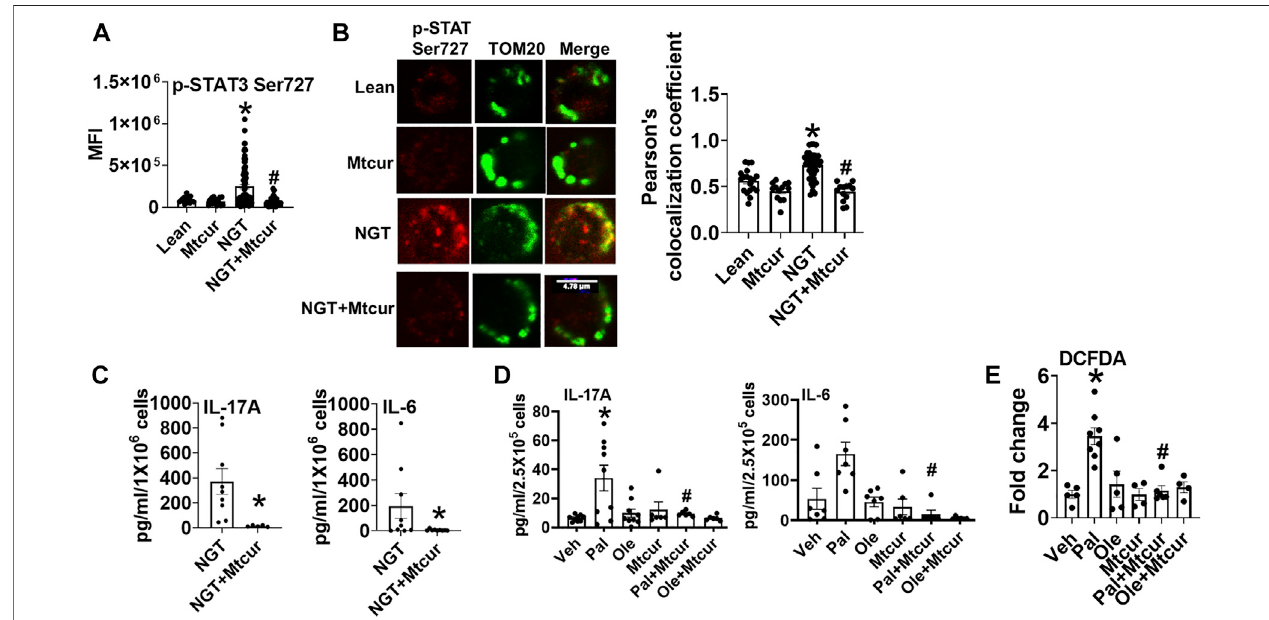
FIGURE 2 | Blocking p-Ser 727- STAT3 translocation into mitochondria prevents proin fl ammatory cytokine production. (A) Expression and (B) mitochondrial localization (left panel , representative images, and right panel quanti fi cation) of p-Ser 727 STAT3 in cells from lean and NGT subjects (C) Cytokine production in cells from NGT subjects; (D) cytokine production in cells from lean subjects after Mtcur as measured by bio-plex assay. (E) Cellular peroxide production. N = 4 – 8, (A,B) and N=7 – 9, (C,D) .N=5 – 8,E.EachNrepresentscellsobtainedfromonesubject.Atleast7 – 10 fi eldsperslidewereimagedat63×magni fi cationwithoilimmersion,on a Zeiss LSM 800 confocal microscope. In fi elds where numerous cells/ fi elds were observed, the averages are plotted. The brightness of the images was enhanced to improve clarity. * p < 0.05 vs lean or veh, # p < 0.05 vs palmitate treatment. * p < 0.05 vs lean or veh, # p < 0.05 vs NGT or palmitate treatment.